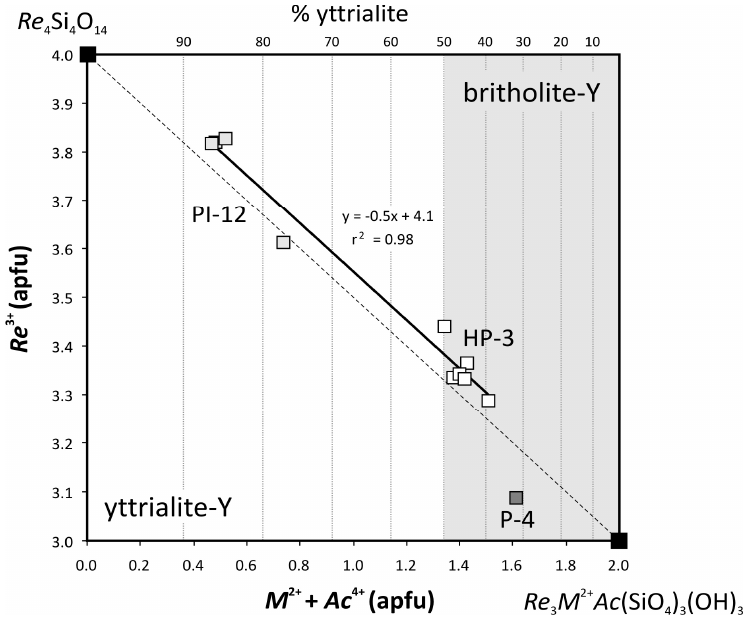
Figure 8. Substitutions in low-Th yttrium silicates from Pinciná maar inferred from atomic propor- tions recalculated using eight cations. Re and Ac refer to Y + REE and Th + U, respectively. M 2+ designates large divalent cations (Fe, Ca, Mn,